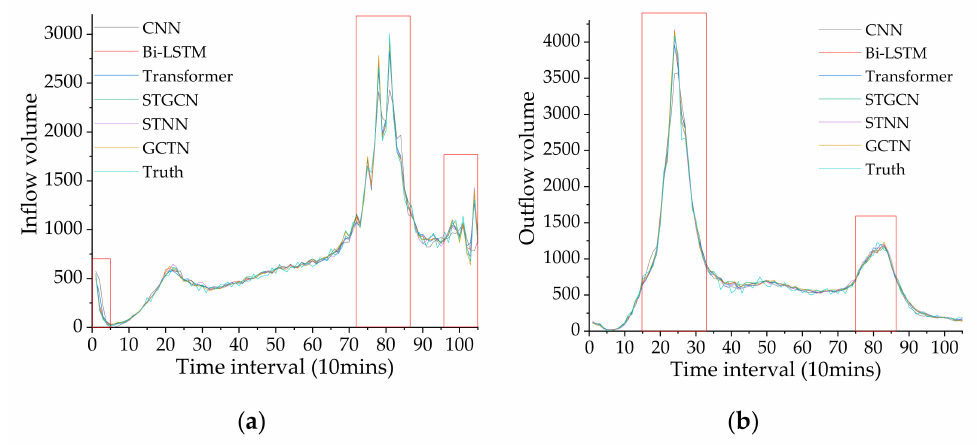
Figure 13. The time period that the passenger flow changes quickly in the Xujiahui Station. ( a ) Inflow volume; ( b ) Outflow volume.